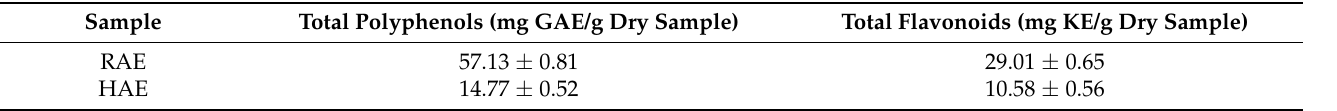
Table 2. Total polyphenols and flavonoids in MS